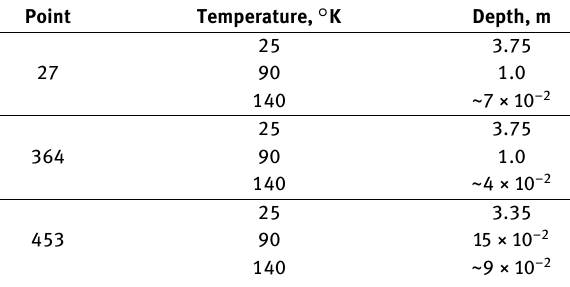
Table 1. Critical temperatures distribution